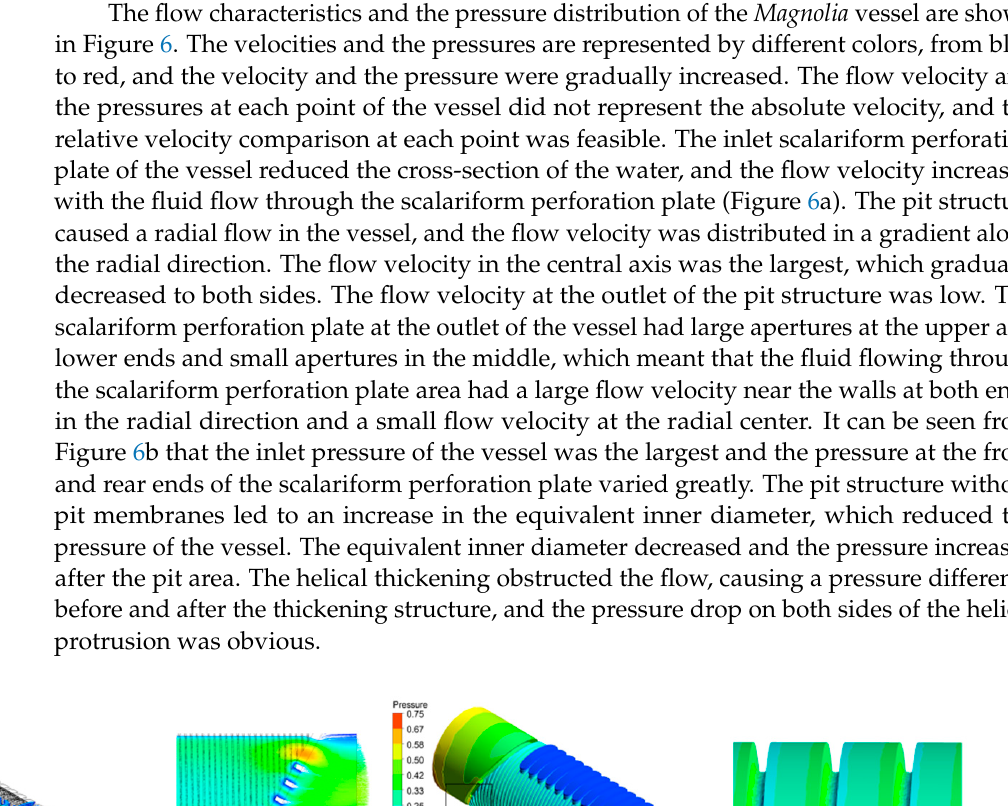
Table 2. Influence of the vessel structure on flow resistance.